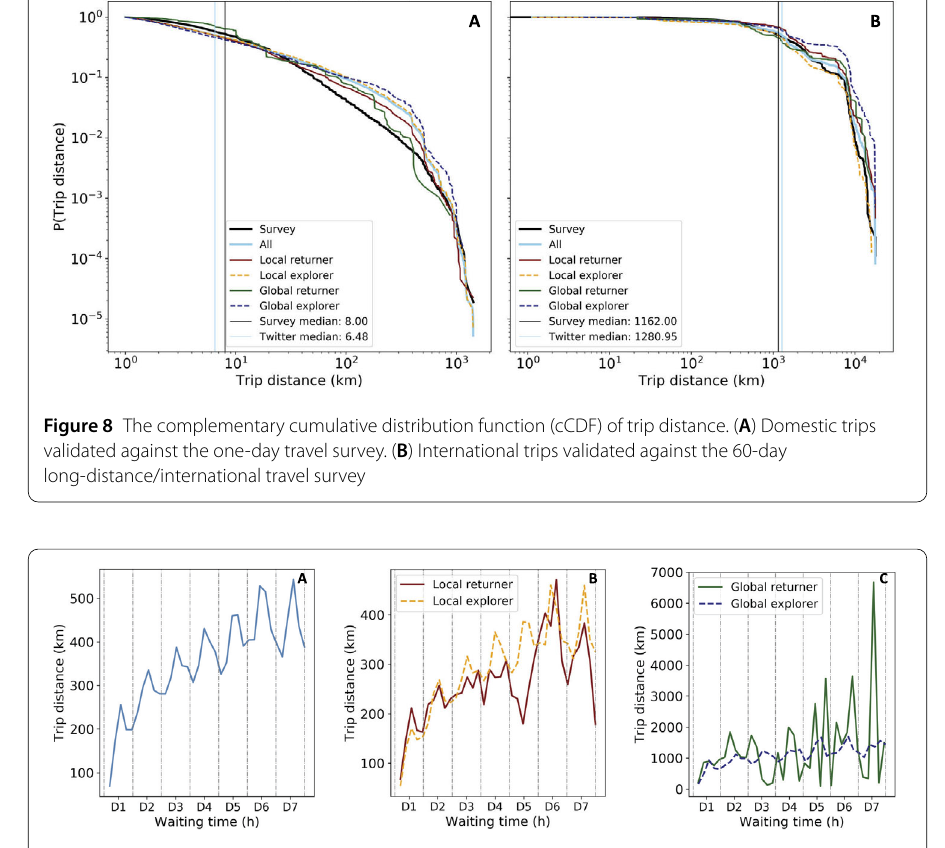
Figure 9 Trip distance vs. waiting time during 7 days. ( A ) All travellers. ( B ) Local travellers. ( C ) Global travellers. Waiting time is defined as the time interval between two consecutive geotagged tweets generated by the same Twitter